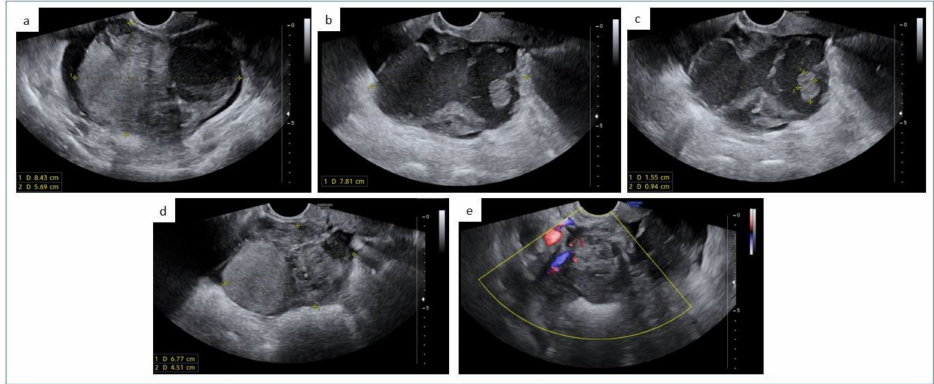
Figure 1. ( a – e ) In right adnexal site a multilocular solid-cystic mass (88 × 57 × 78 mm) has been observed, with ground grass content, complete/incomplete septa ( a , b ) and endoluminal papillae (15 × 9 mm, the largest one, ( c )). The solid component measured 68 × 45 mm ( d ) and it was moderately vascularized at Color Doppler ( e